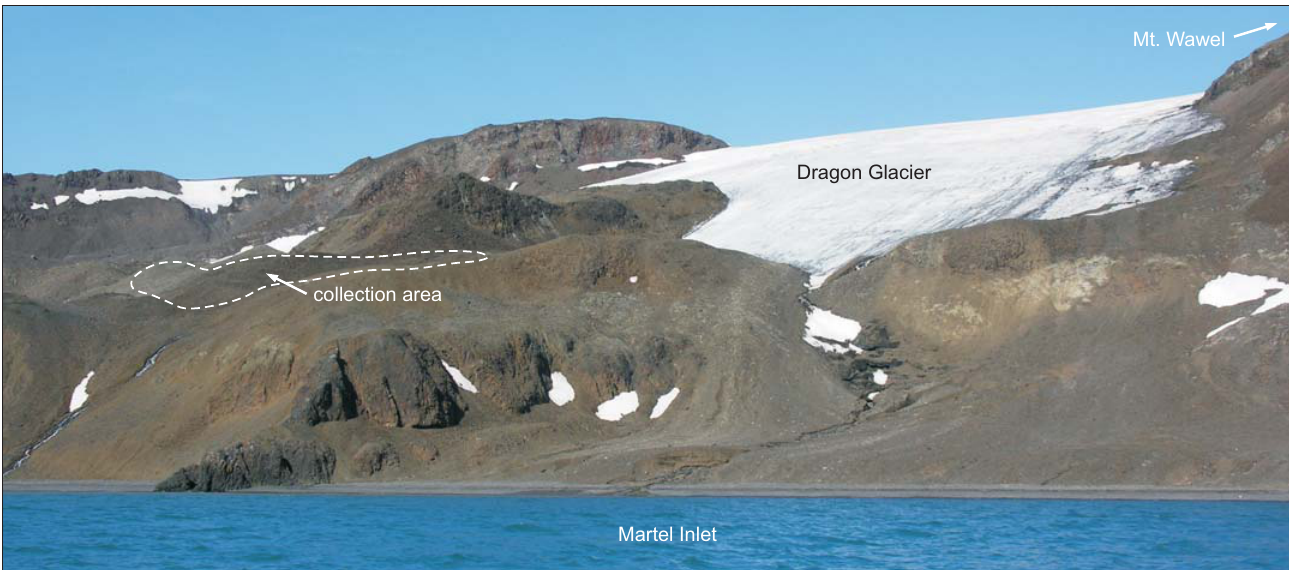
Fig. 2. Location of plant and trace fossil collection area as seen from Martel Inlet, Admiralty Bay, King George Island, Antarctica. Photograph by AG, January